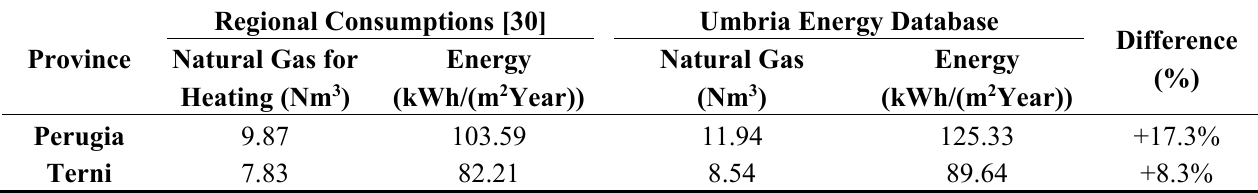
Table 4. Comparison between official and energy database values for Umbria buildings.